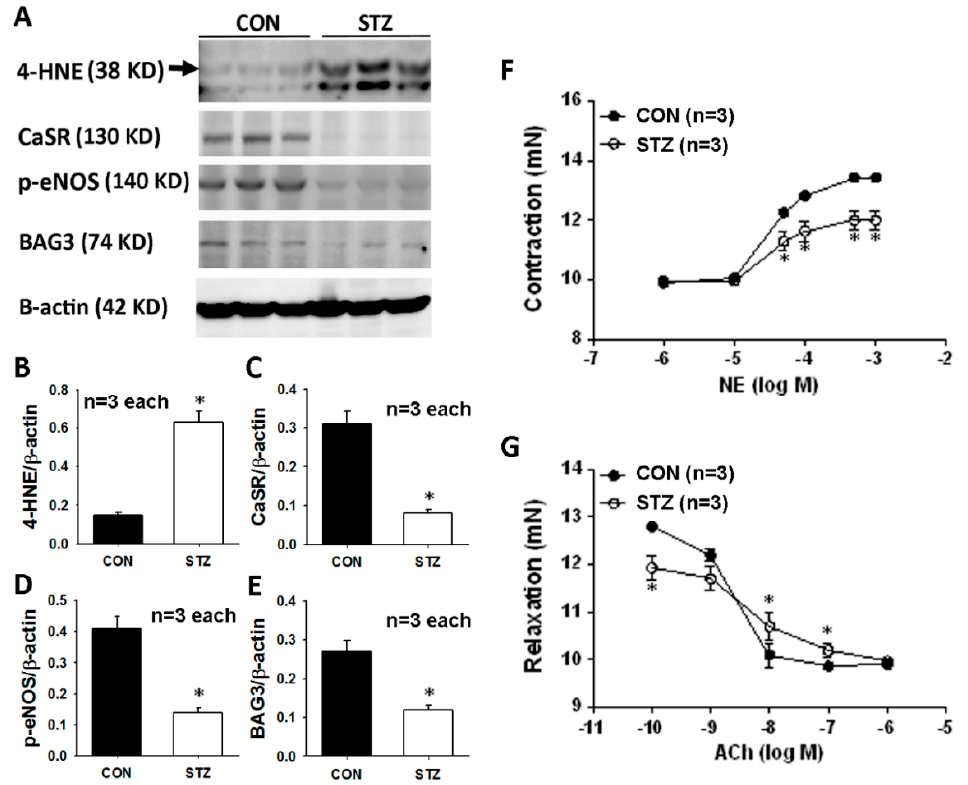
Figure 2. Mesenteric vascular Western blot graph ( A ) and analysis of 4-HNE ( B ), CaSR ( C ), p-eNOS ( D ) and BAG3 ( E ) are demonstrated. Microvascular reactivity from mesenteric arterioles to a vasoconstrictor (norepinephrine, NE, F ) and vasodilator (acetylcholine, Ach, G ) is displayed in CON and STZ groups. All data are presented as the mean ± SEM ( n = 3) using the single values in each test. * p < 0.05 vs. CON group.